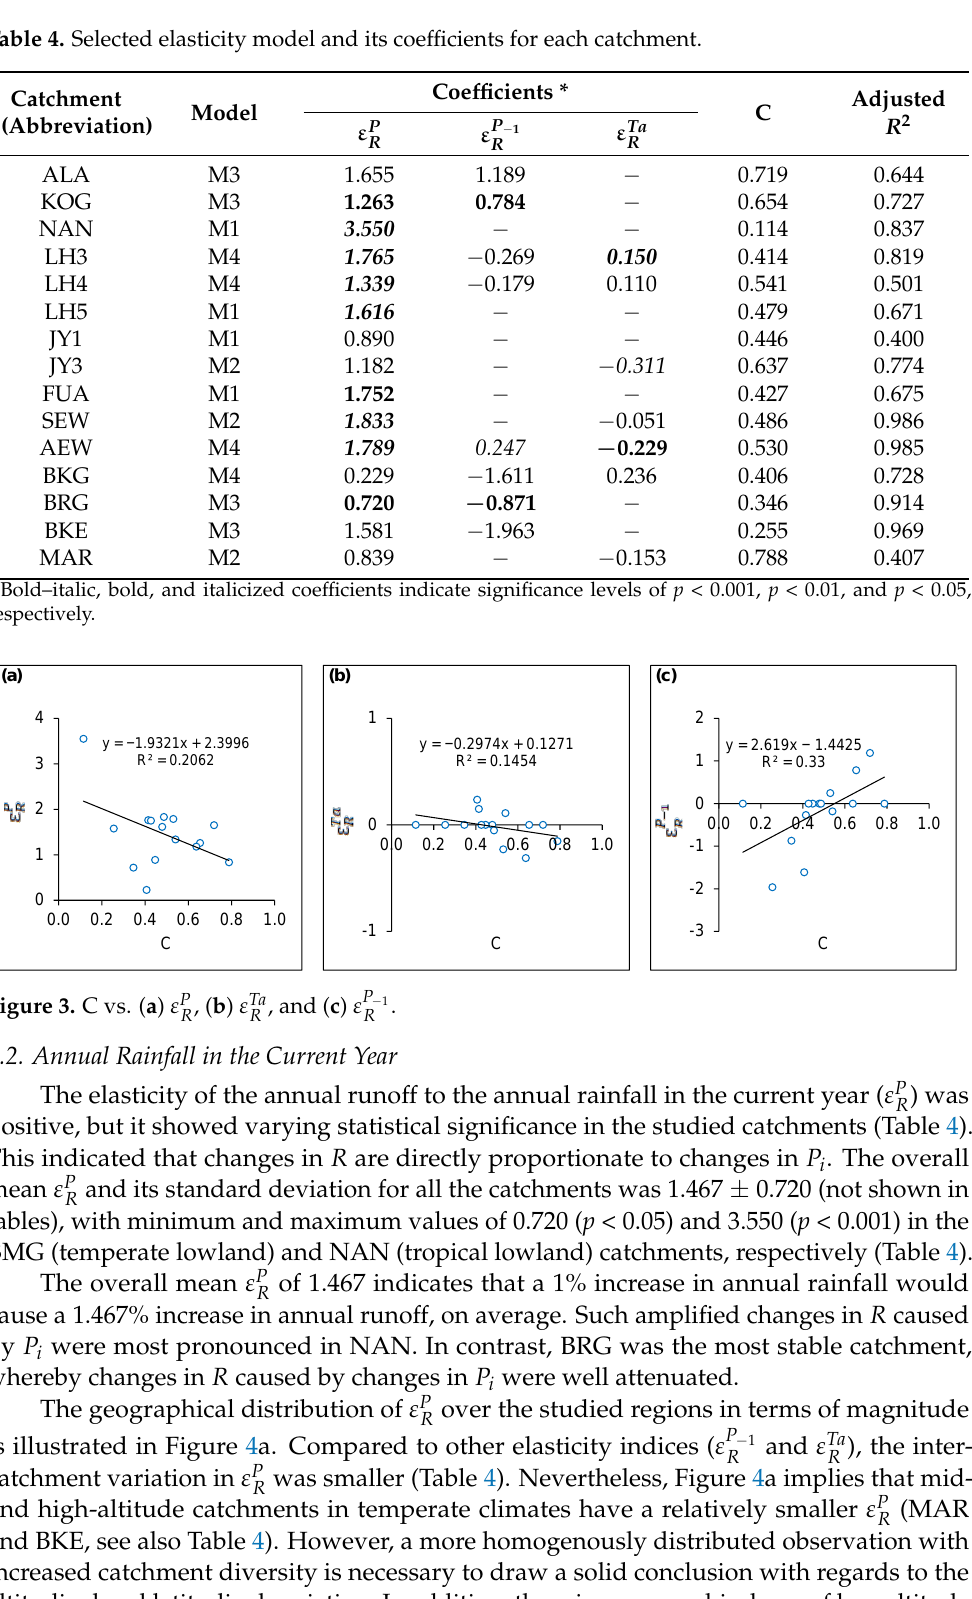
Table 4. Selected elasticity model and its coefficients for each catchment.